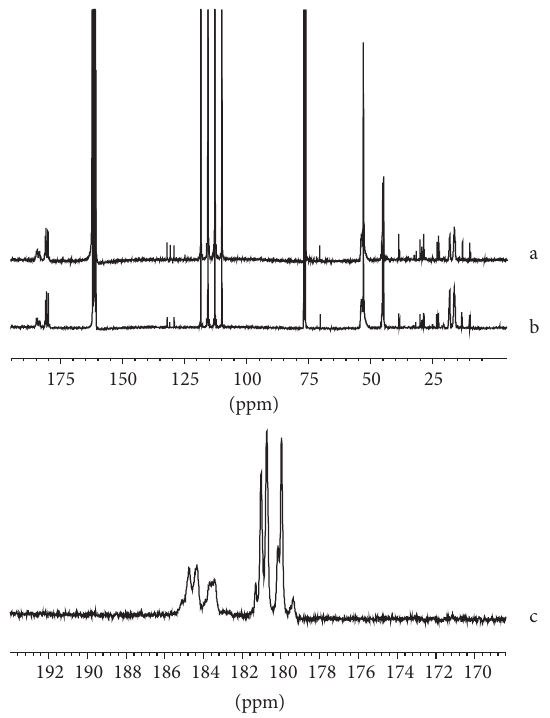
Figure 5: 13C-NMR spectra of samples from the copolymerization of MMA/MAA (2/1, mol/mol) taken at global conversions of (a) 8.0 and (b) 89.7%. The segment of the spectrum of the sample at 89.7% in global conversion at which the syndiotacticity is evidenced is also included (c).